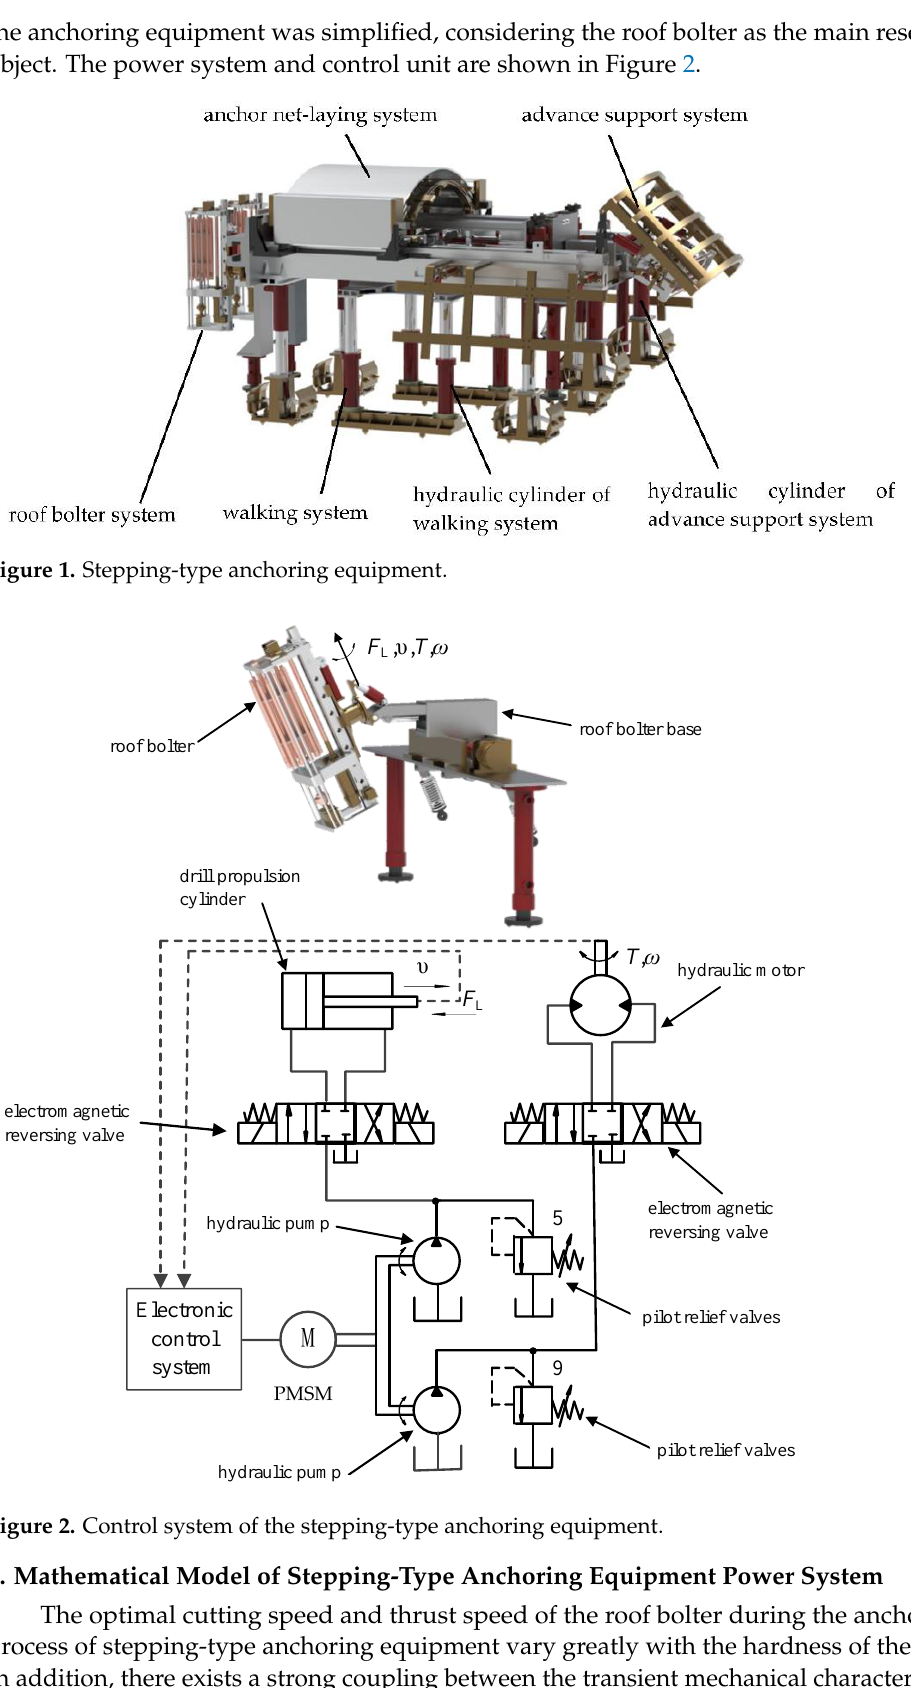
Figure 2. Control system of the stepping-type anchoring equipment.